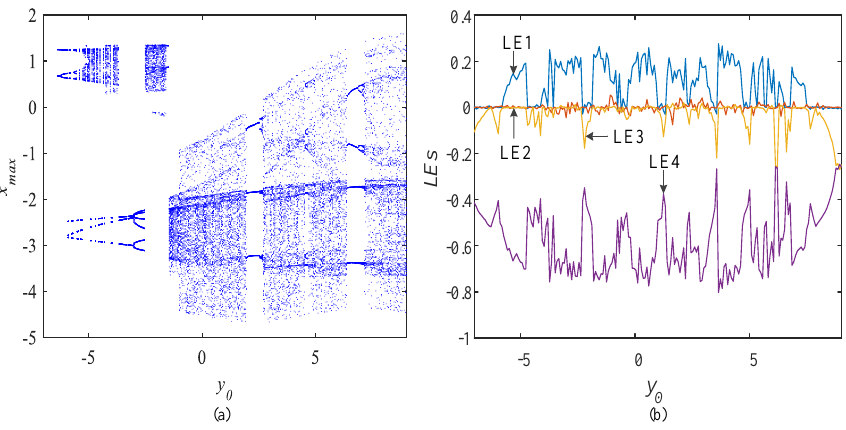
Figure 7. Dynamics with y 0 change: ( a ) bifurcation diagram; ( b ) Lyapunov exponents. The control parameters and order of the system (8) remain unchanged, and change the initial value to x 0 = 1, y 0 = 1, z 0 = 1; w 0 varies at the range [ − 7, 8]. The bifurcation dia- gram and the LEs of the system (8) are shown in Figure 8. As w 0 increases, it is obvious that the bifurcation diagram can be divided into five intervals of [ − 7, − 5], ( − 5, − 1.9], ( − 1.9,5], (5,6.7], (6.7,8] numbered 1–5. These five intervals have a certain degree of symmetry. In interval 1 and 5, the system evolves into a chaotic state through forward (reverse) period- doubling bifurcation. Then, the system entered interval 2 and 4 and re-evolved. In interval 3, the system is chaotic, except for a few periodic windows. LEs have more severe oscilla- tions than Figure 7b. This is because the system state switches rapidly between periodic and chaotic. This phenomenon can be seen from interval 4 of the bifurcation